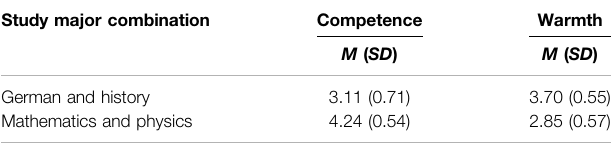
TABLE 4 | Competence and warmth ratings of pre-service teachers with different study major combinations in Study 3b (closed-ended questions). Study major combination